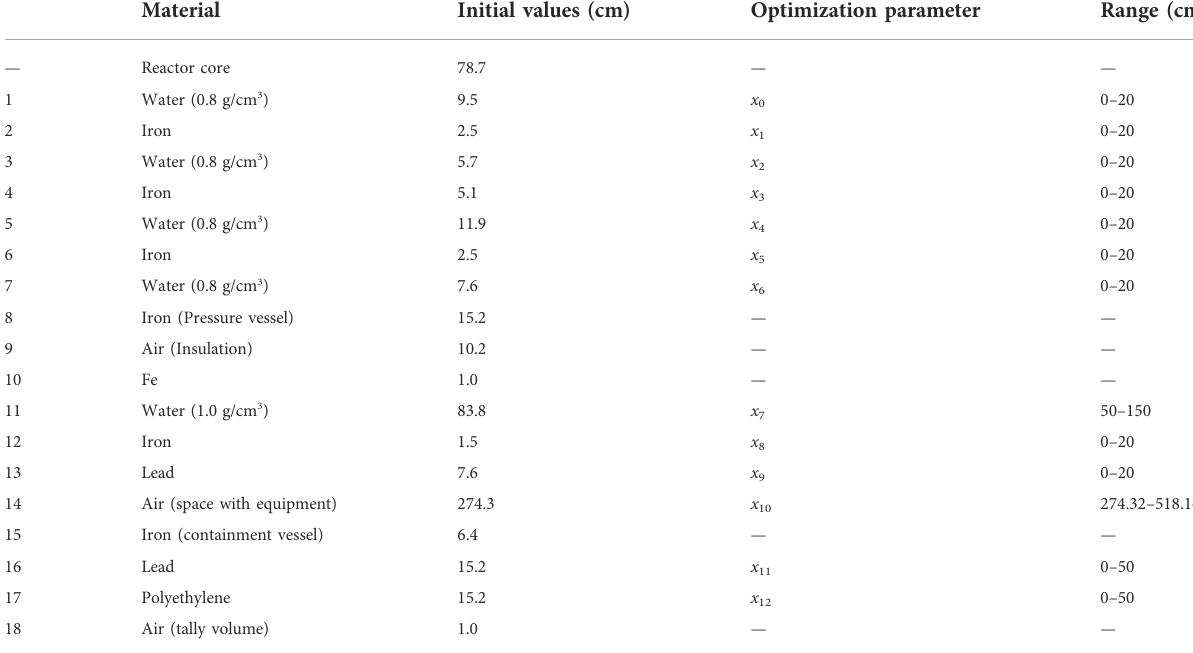
TABLE 1 Structure of the Savannah reactor shield and the optimization